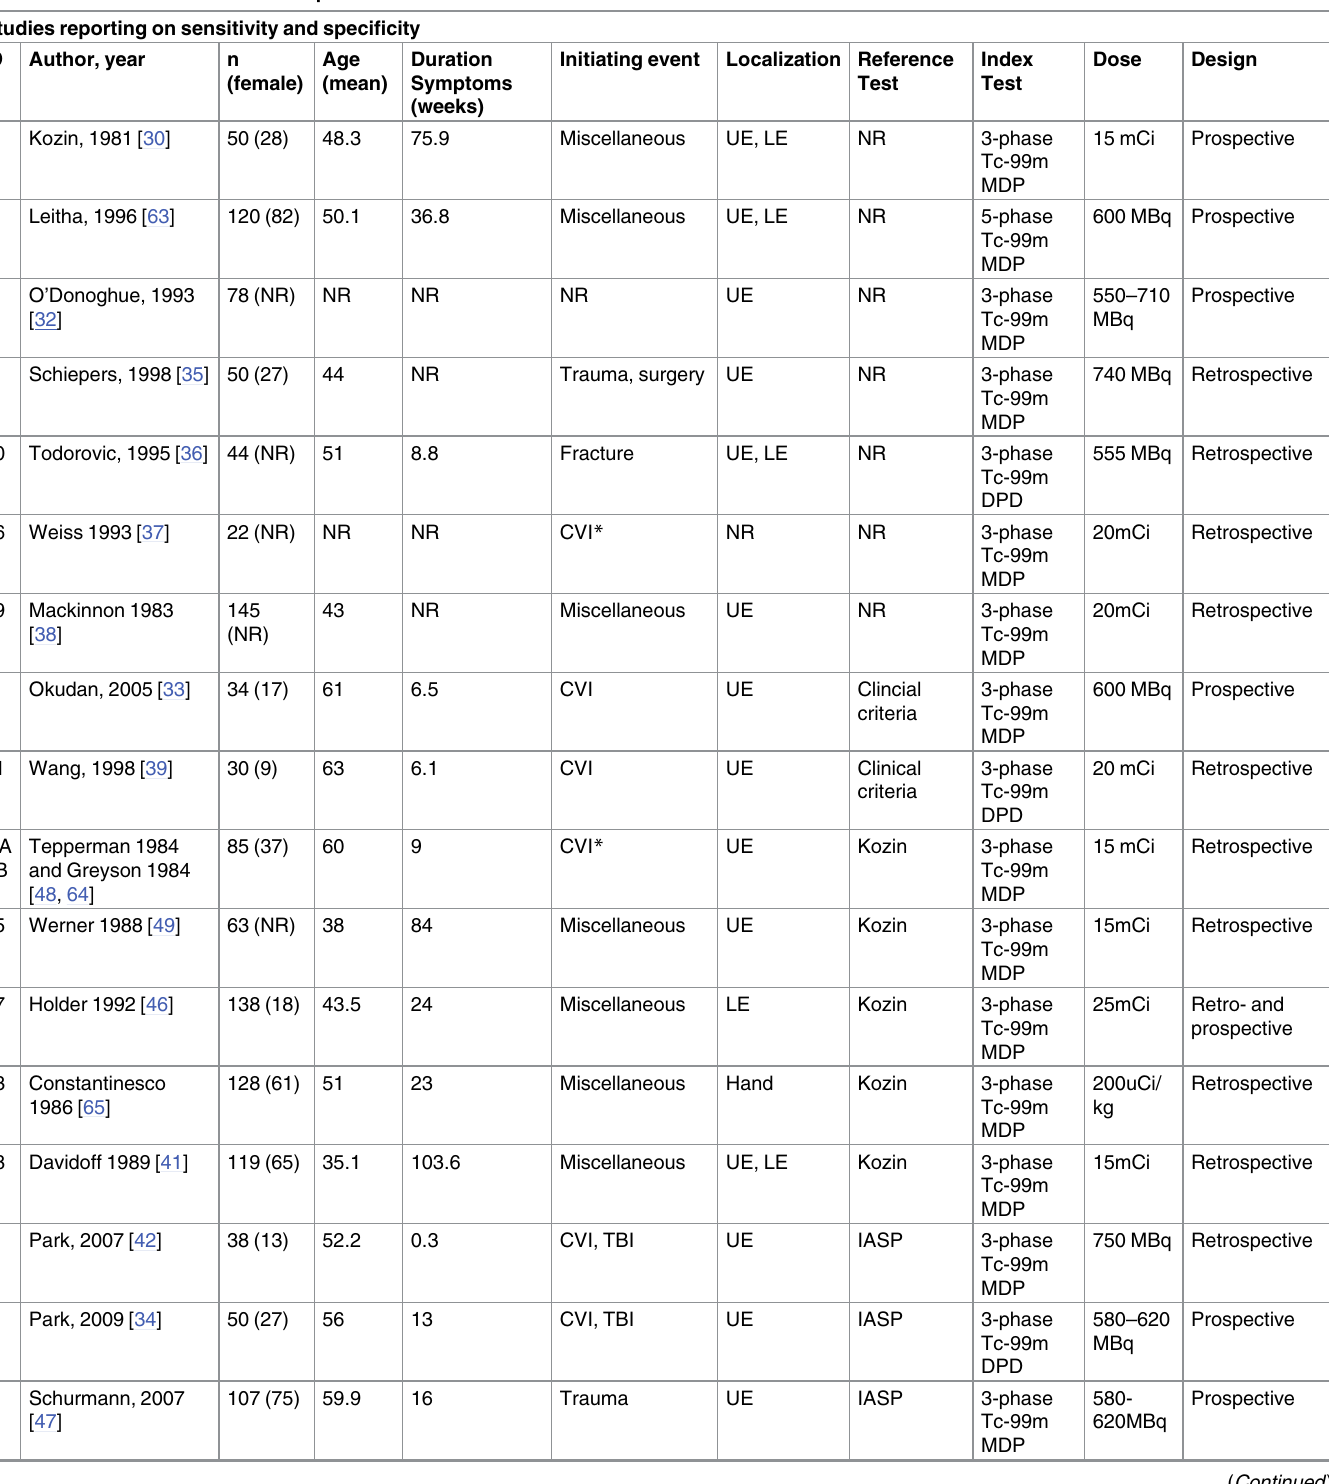
Table 1. Baseline characteristics of patients included in the studies Studies reporting on sensitivity and